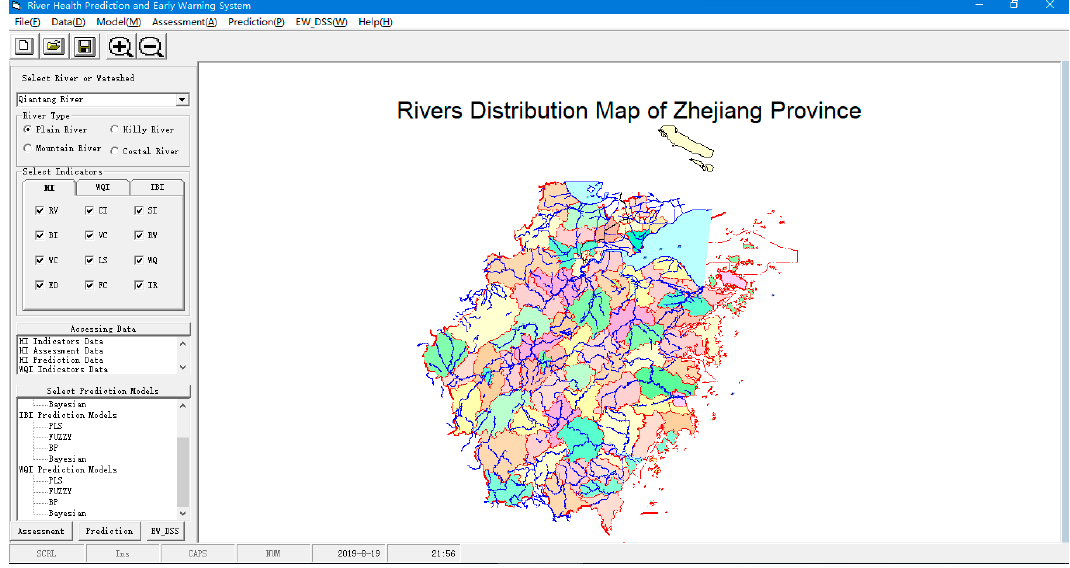
Figure 4. Geographic user interface of RHP-EWS.